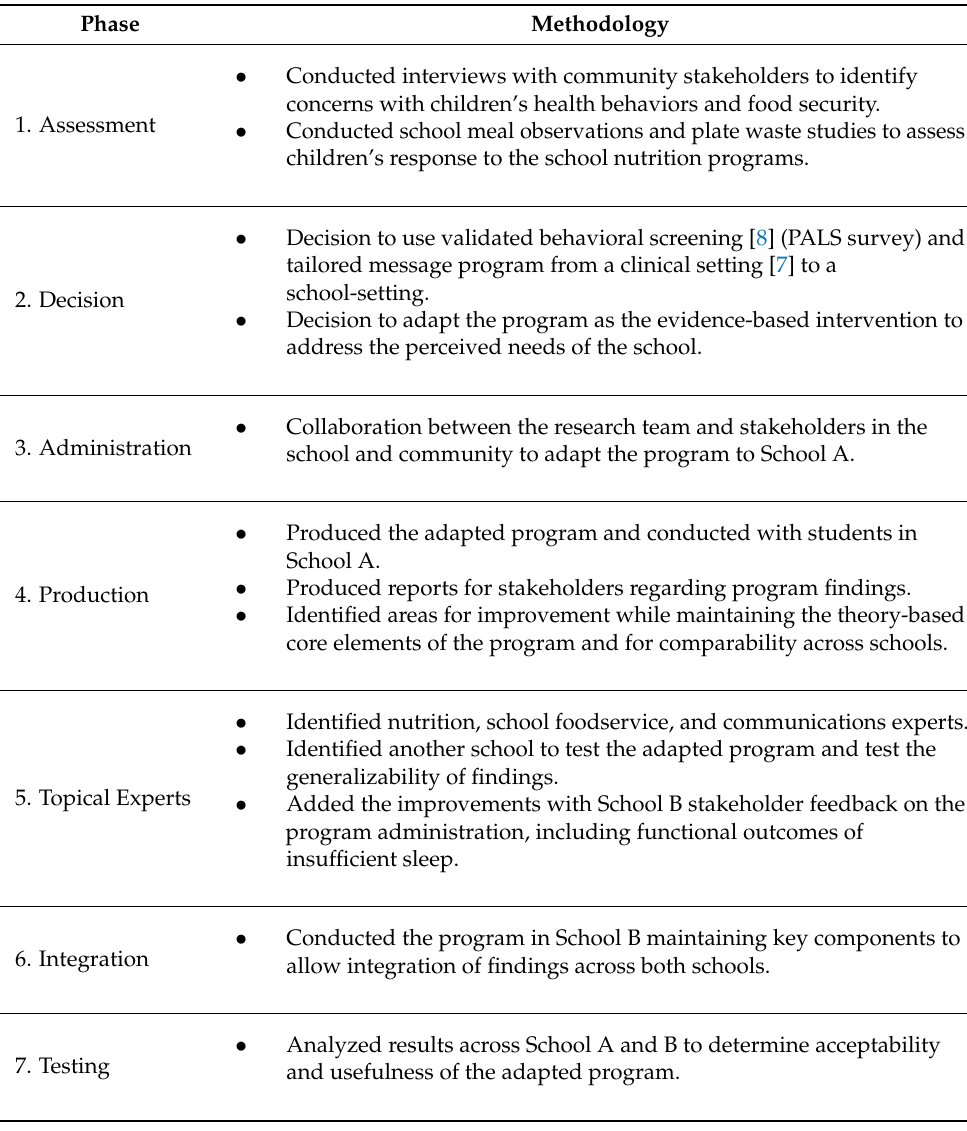
Table 1. Applying the modified ADAPT-ITT Model [26] to the Pediatric Adapted Liking Survey (PALS) plus tailored messages program for students in school A and school